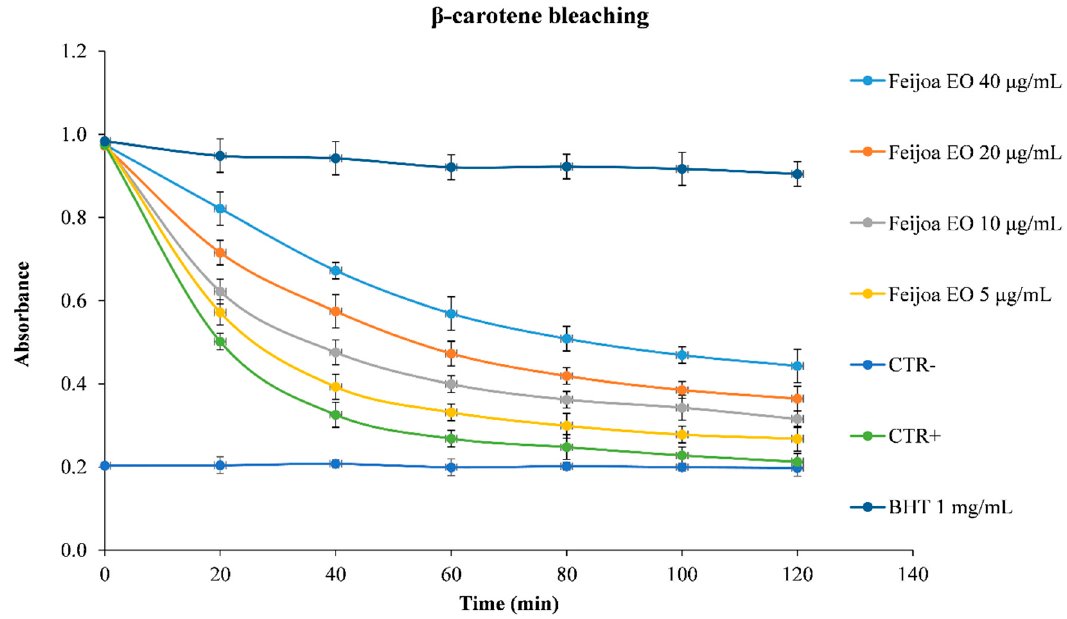
Figure 4. β -Carotene bleaching kinetic curves of the different concentrations of feijoa EO compared to the reference standard butylated hydroxytoluene (BHT) 1 mg/mL.